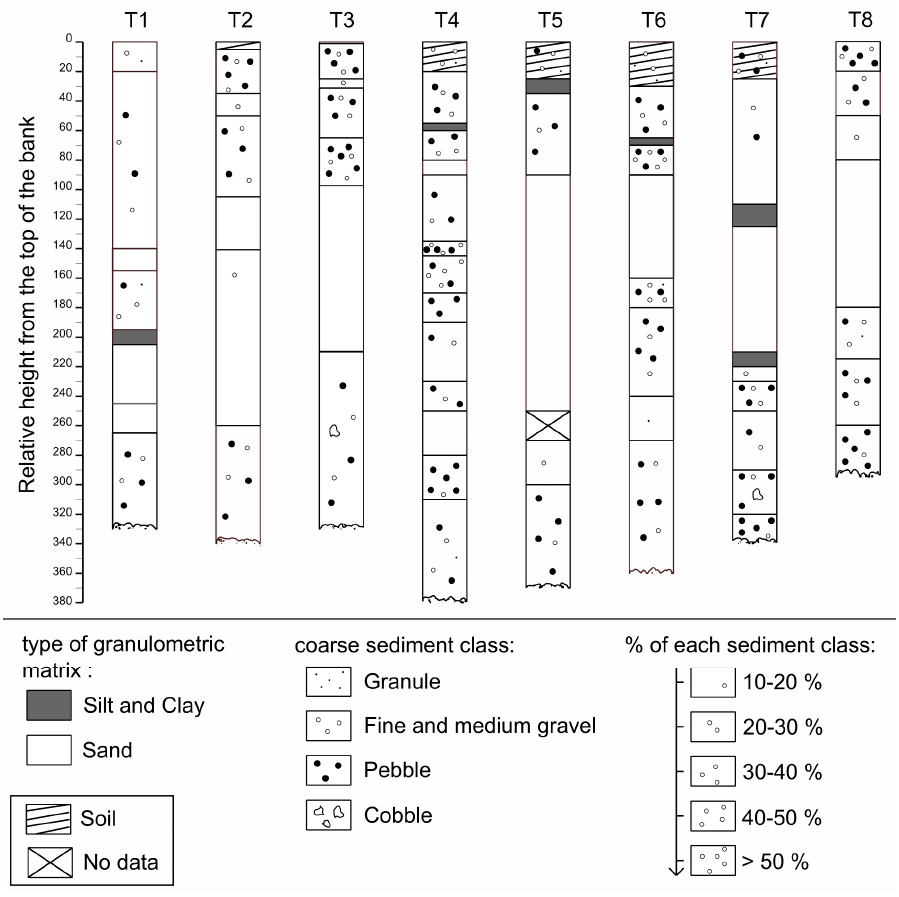
Figure 9. Stratigraphic and granulometric composition of the restored bank at Site 2.